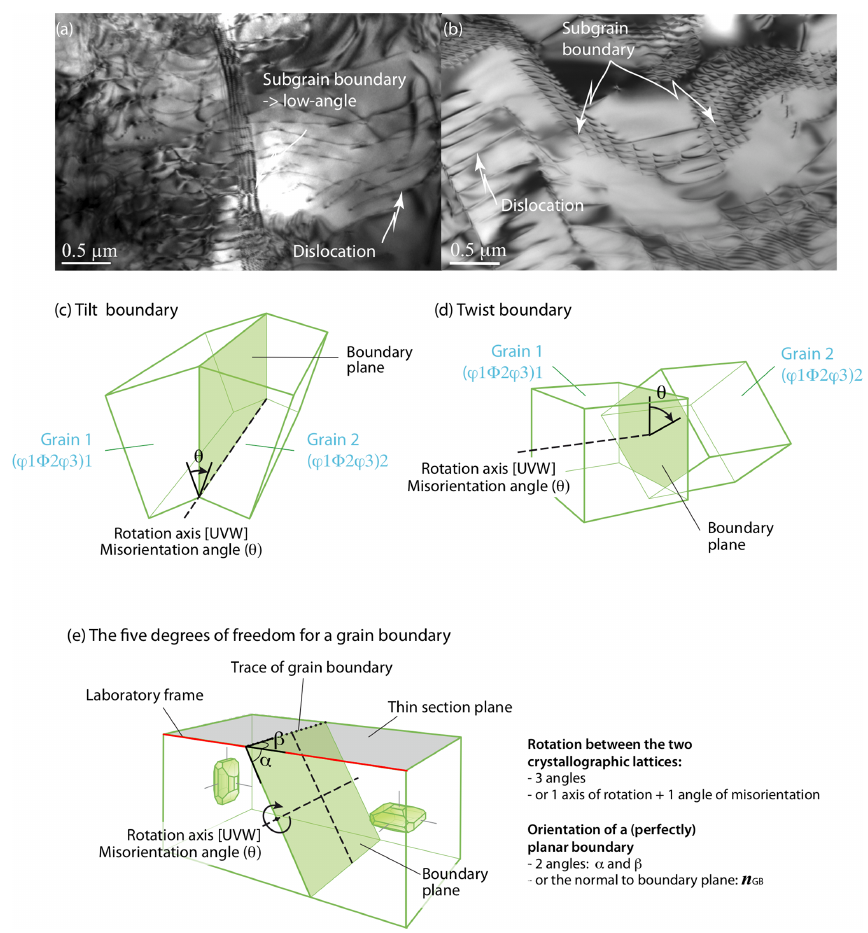
Figure 8. TEM images (courtesy of Patrick Cordier) and sketches of grain boundaries: (a) TEM image showing an almost planar subgrain boundary in nanoforsterite deformed at 0.3GPa and 1200 ◦ C (sample NF1200-1 from Gasc et al., 2019); (b) subgrain boundary crosscut by the TEM foil plane in a natural San Carlos olivine (He-doped sample PB3 from Burnard et al., 2015); (c) low-angle tilt boundary, with the rotation axis within the grain boundary and rotation angle θ ; (d) low-angle twist boundary with the rotation axis perpendicular to the grain boundary and rotation angle θ ; and (e) the five macroscopic degrees of freedom required to define a grain boundary, shown for the example of a high-angle tilt boundary with [100] as the axis of